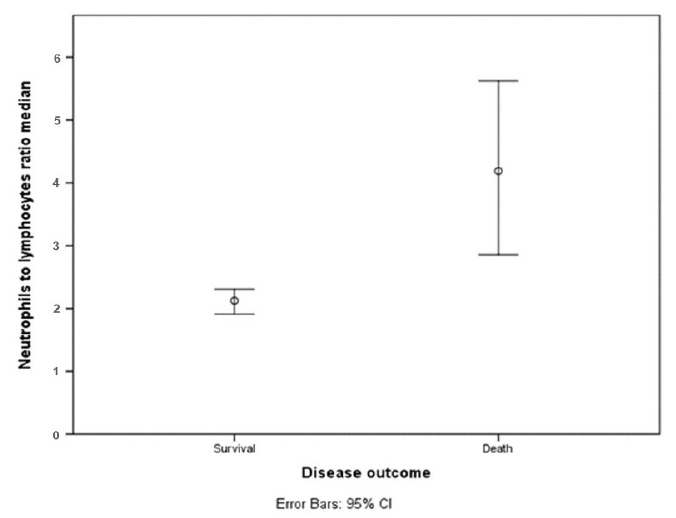
Figure 3. Median and CI of NLR in survivors and deceased patients. NLR is markedly higher in deceased patients’ group. Median is represented with circle; error bars show 95% CI.